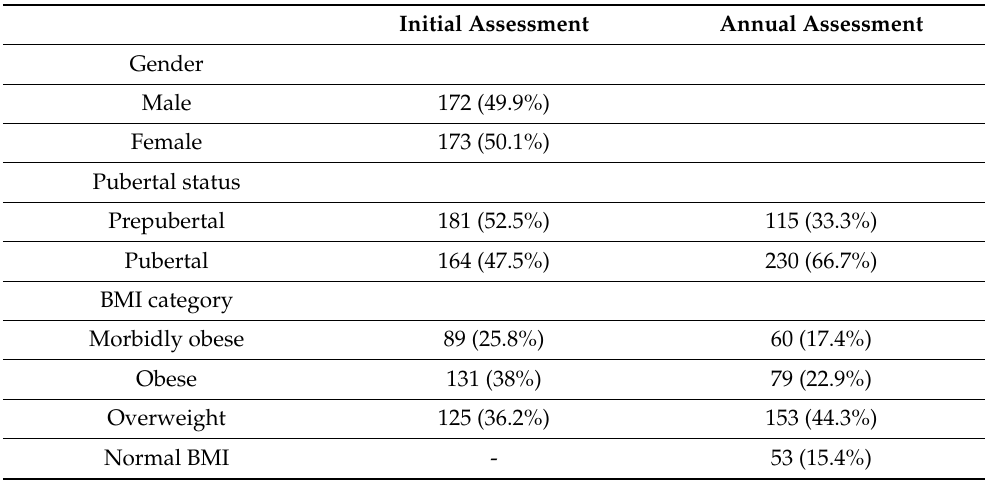
Table 1. Gender, pubertal and BMI category of all subjects at initial and annual